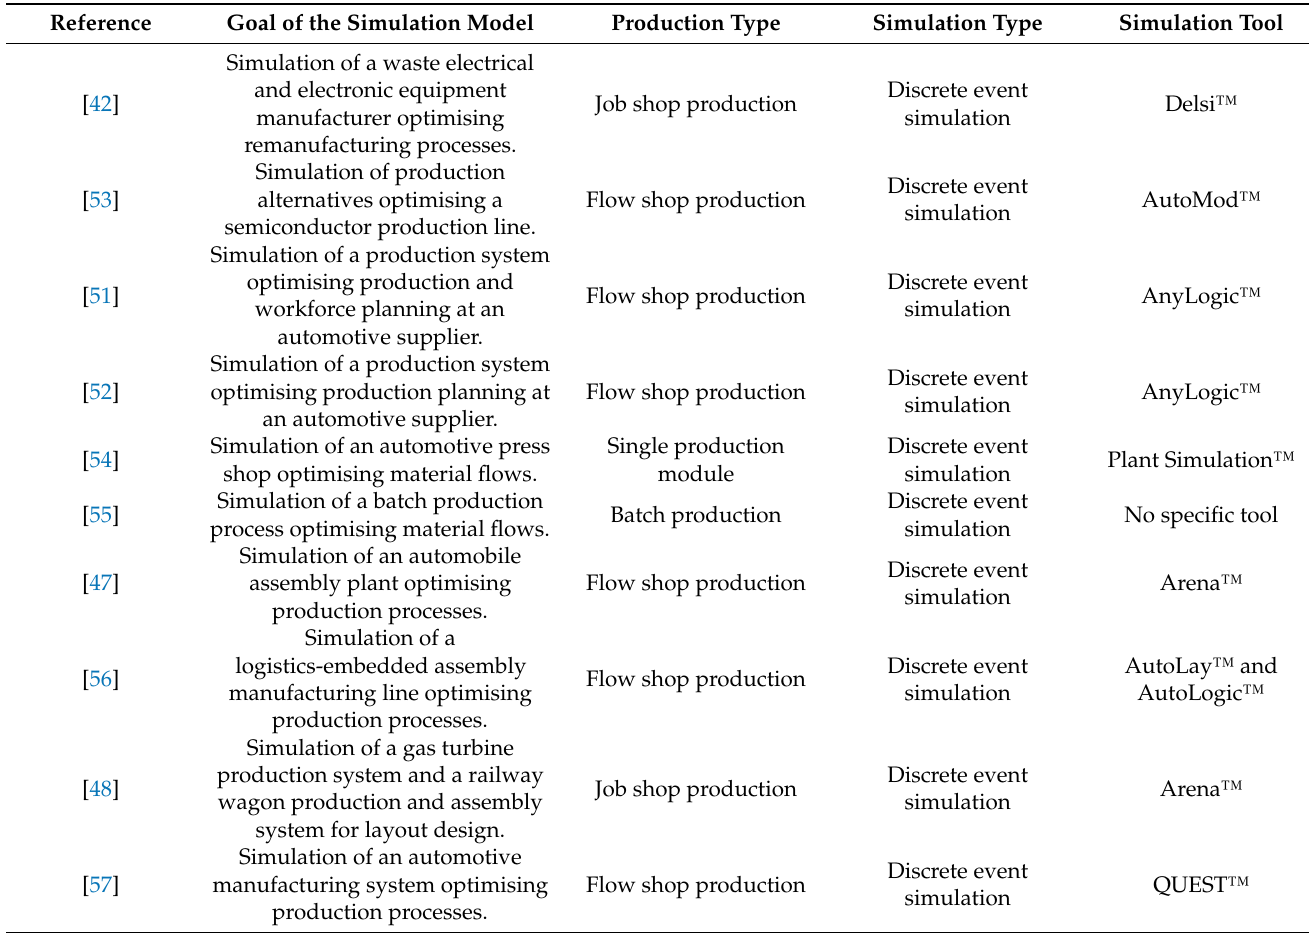
Table 1. Overview of Related Literature Generic Simulation